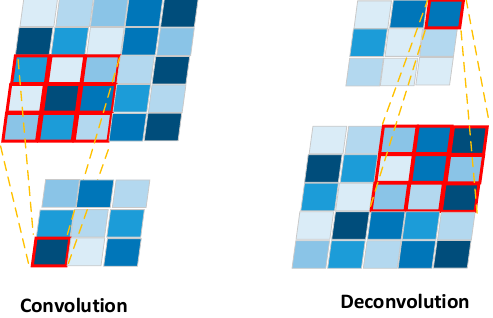
Figure 5. Operations of convolution and deconvolution.